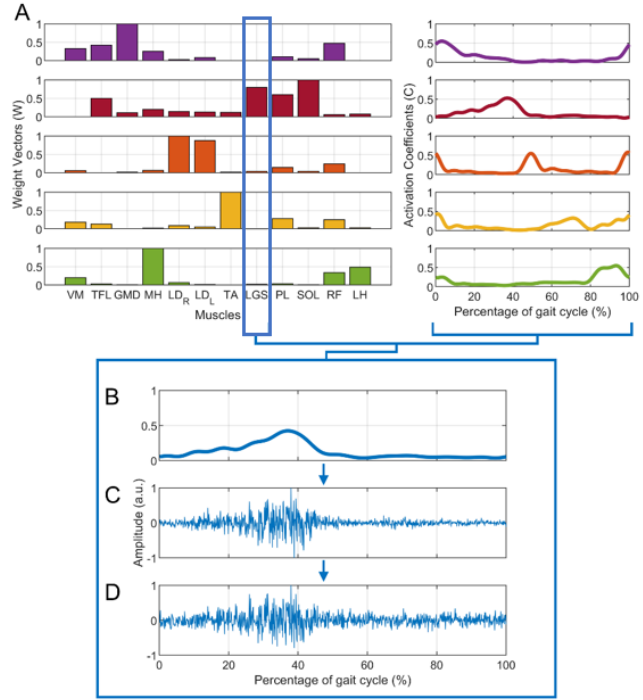
Figure 1. Example of the generation of a simulated sEMG signal for the lateral gastrocnemius (LGS) muscle: the first step is ( A ) the extraction of muscle synergies ( 𝑊 and 𝐶 ) from the real data of a representative subject with 5 muscle synergies, the second is ( B ) the reconstruction of the LGS envelope (obtained as 𝑊 LGS * 𝐶 ). Then, ( C ) a simulated sEMG signal without additive noise is generated. Finally, noise is added to the previous signals. An example of a simulated sEMG signal with SNR = 20 dB is shown in ( D ).